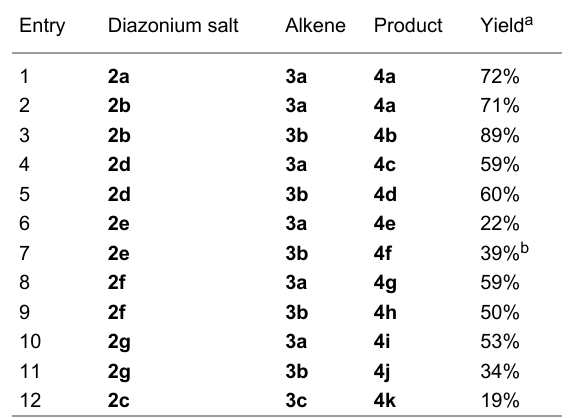
Table 1: Results of the reaction between diazonium salts 2 and alkenes 3